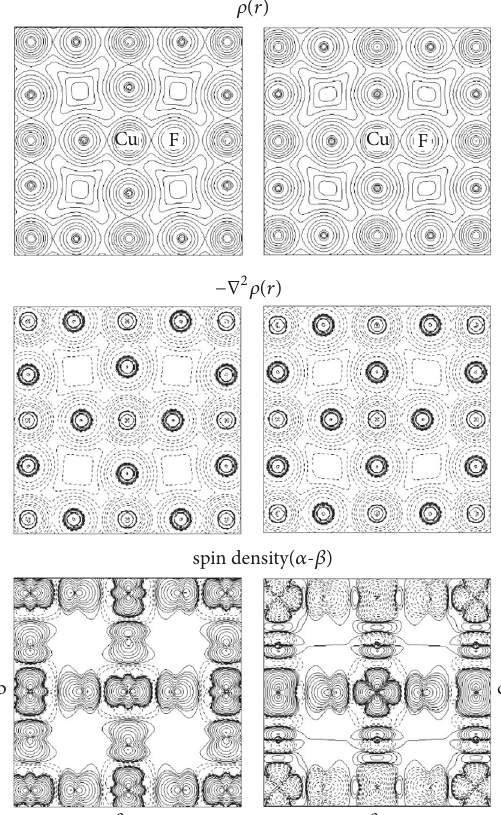
Figure 2: Contour plots of the electron density, the Laplacian of the electron density changed in sign and spin density in pure KCuF 3 . Left panels refer to the ab and the right panels to the ac plane. Full and dashed lines indicate positive and negative values of the plotted function, respectively. Plots refer to the AF1 phase.